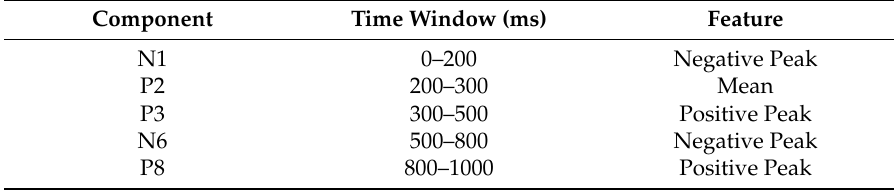
Table 1. Component values of correctness and error under static and dynamic visual stimulations.